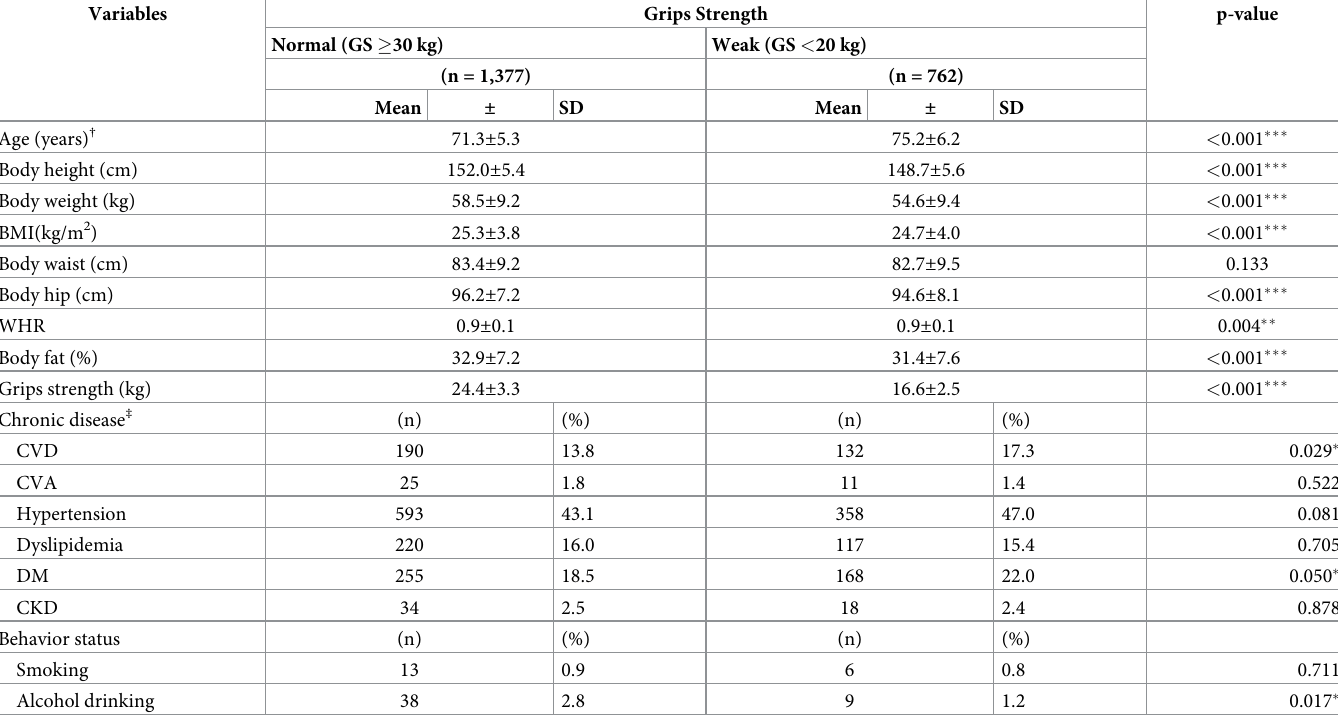
Abbreviations: BMI, Body mass index; WHR: Body waist to hip ratio; CVD, Cardiovascular disease; CVA, Cerebrovascular disease; DM, Diabetes mellitus; CKD, Chronic kidney disease. † t test was compared with grip strength normal and grip strength weak among characteristics of anthropometry and grip strength; ��� p < 0.001, �� p < 0.01, � p < 0.05. � p <